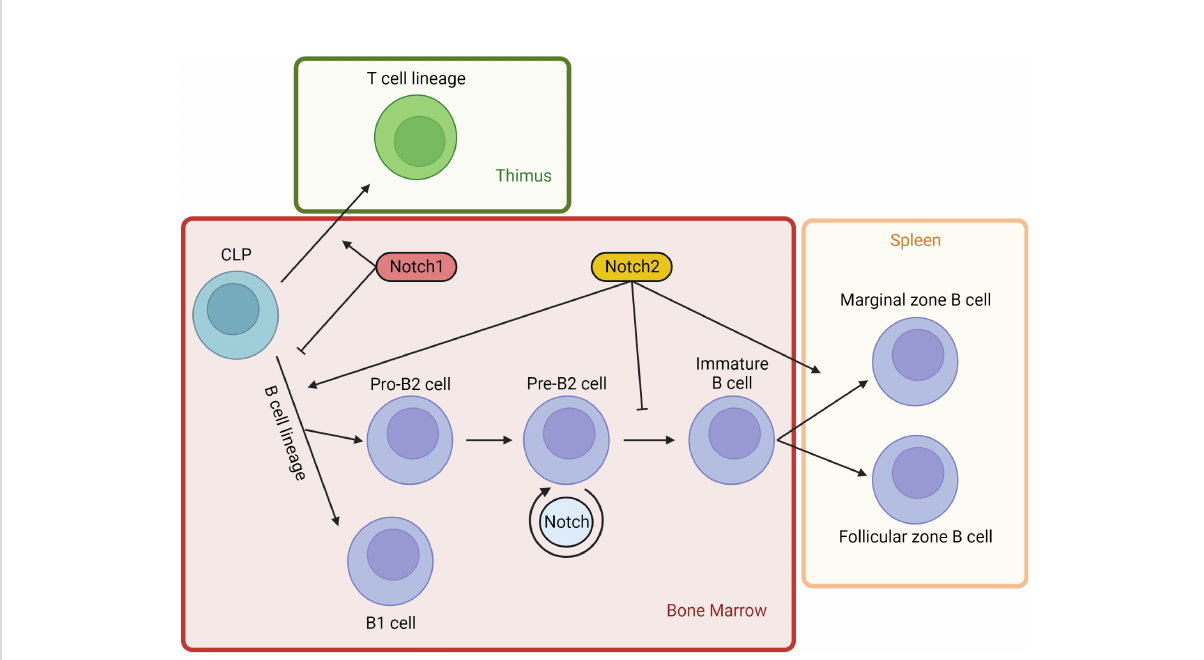
FIGURE 4 Notch signaling in lymphopoiesis. Notch activity in fl uences multiple lineage decisions of developing lymphoid cells. Lymphopoiesis starts in the BM from CPLs (common lymphoid progenitors). A part of BM progenitors moves through the bloodstream into the thymus, where Notch1 activity stimulates T cells development from CLPs. Contrariwise, lineage B commitment is inhibited in CLPs by Notch1 pathway. Early B cell development from CLPs is induced by Notch2 signaling, independently of B1 or B2 branching. However, Notch2 activity blocks B2 cell progression at pre-B stage. Developing B cells can themselves express DLL, establishing a dynamic balance that maintains some lymphocytes at a precursor state. DLL1 is the most important physiological Notch2 ligand and it is not expressed by BM cells. DLL1 presence at high concentrations in splenic venules induces immature B cells homing to the spleen, where Notch2 activation DLL1-mediated induces immature B2 cells to differentiate into marginal zone B